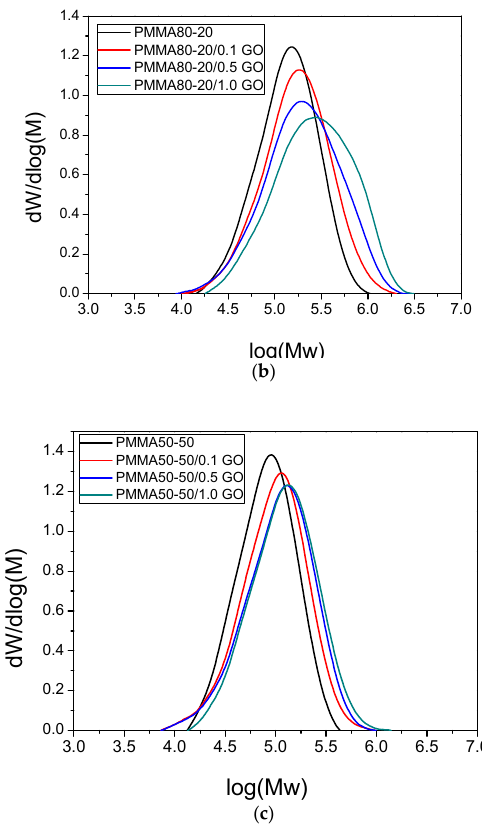
Figure 6. Full Molecular weight distribution of neat PMMA and PMMA/GO nanocomposites obtained in bulk ( a ) and solution with a 80–20 ( b ) and 50–50 ( c ) ratio of monomer to solvent. Table 2. Number-average, weight-average, and z-average molecular weights ( M n , M w , M z ), polydispersity of the MWD (PD) and glass transition temperature ( T g ) of neat PMMA and its nanocomposites with various amounts of GO obtained in bulk or solution polymerization with a 80–20 and 50–50 ratio of monomer to